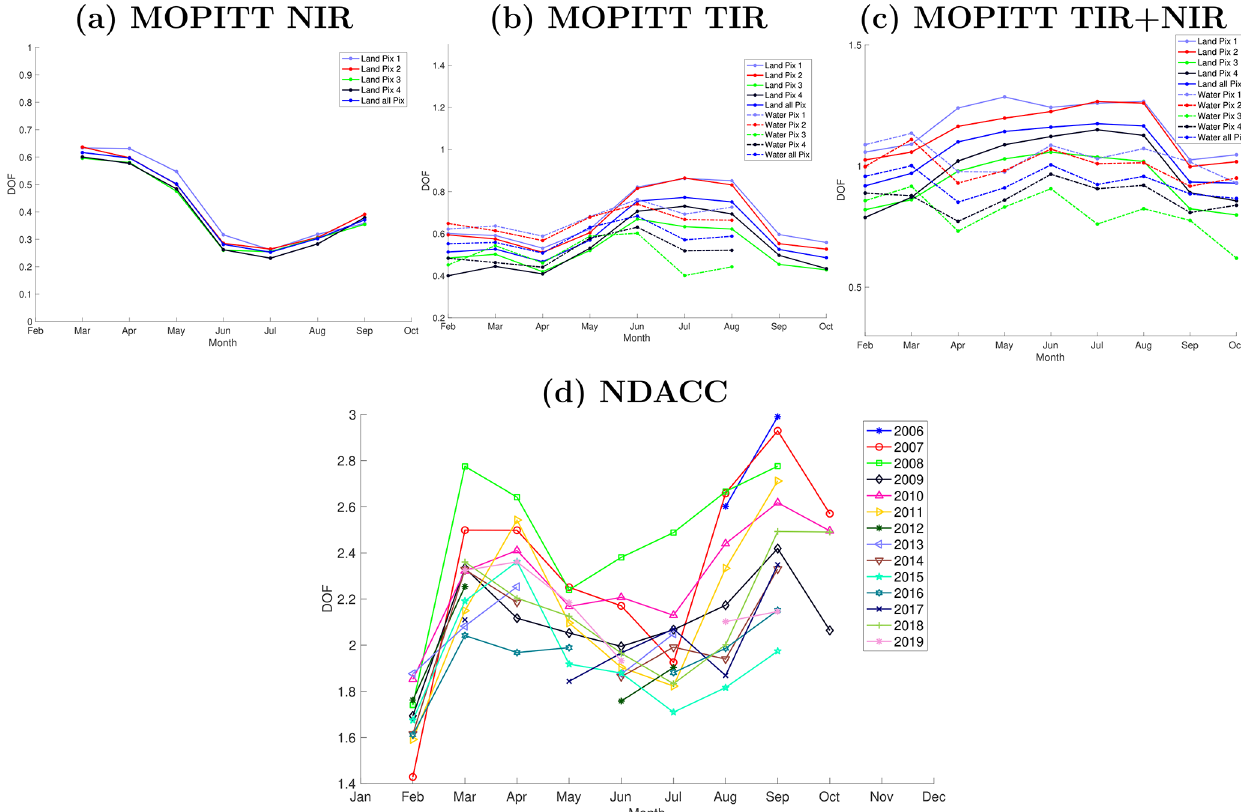
Figure 7. MOPITT monthly average DOFS from 2006 to 2019 for (a) NIR only, (b) TIR only, and (c) multi-spectral joint TIR–NIR. (d) NDACC FTIR monthly DOFS shown by